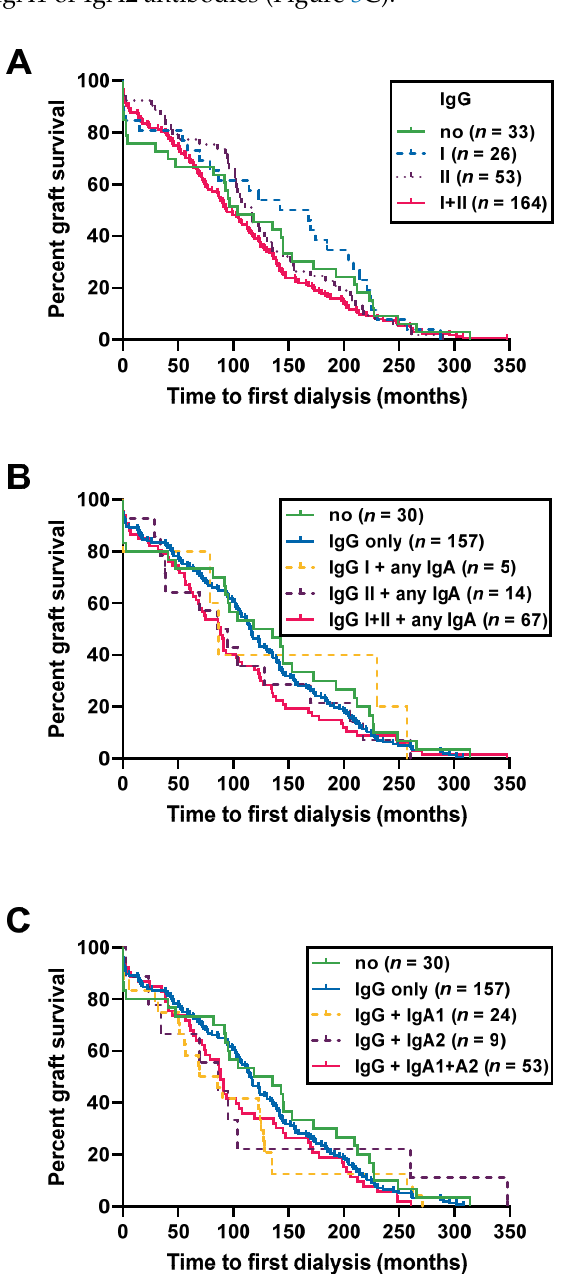
Figure 3. Impact of anti-HLA IgG and IgA antibodies on kidney allograft survival, stratified by HLA-class and isotype, respectively. This analysis includes 276 patients with allograft failure, which again required dialysis. Panel ( A ) shows allograft survival stratified by the presence of IgG antibodies against HLA-class I (I), HLA-class II (II) or both (I+II). Panel ( B ) combines the HLA-specificity of IgG antibodies with the presence of any IgA antibody. Panel ( C ) stratifies survival by IgG antibodies, together with the isotype of IgA antibodies (IgA1/A2). The time to first dialysis was used as a measure of the duration of allograft function. Graft survival of various groups was compared by Log Rank (Mantel–Cox)